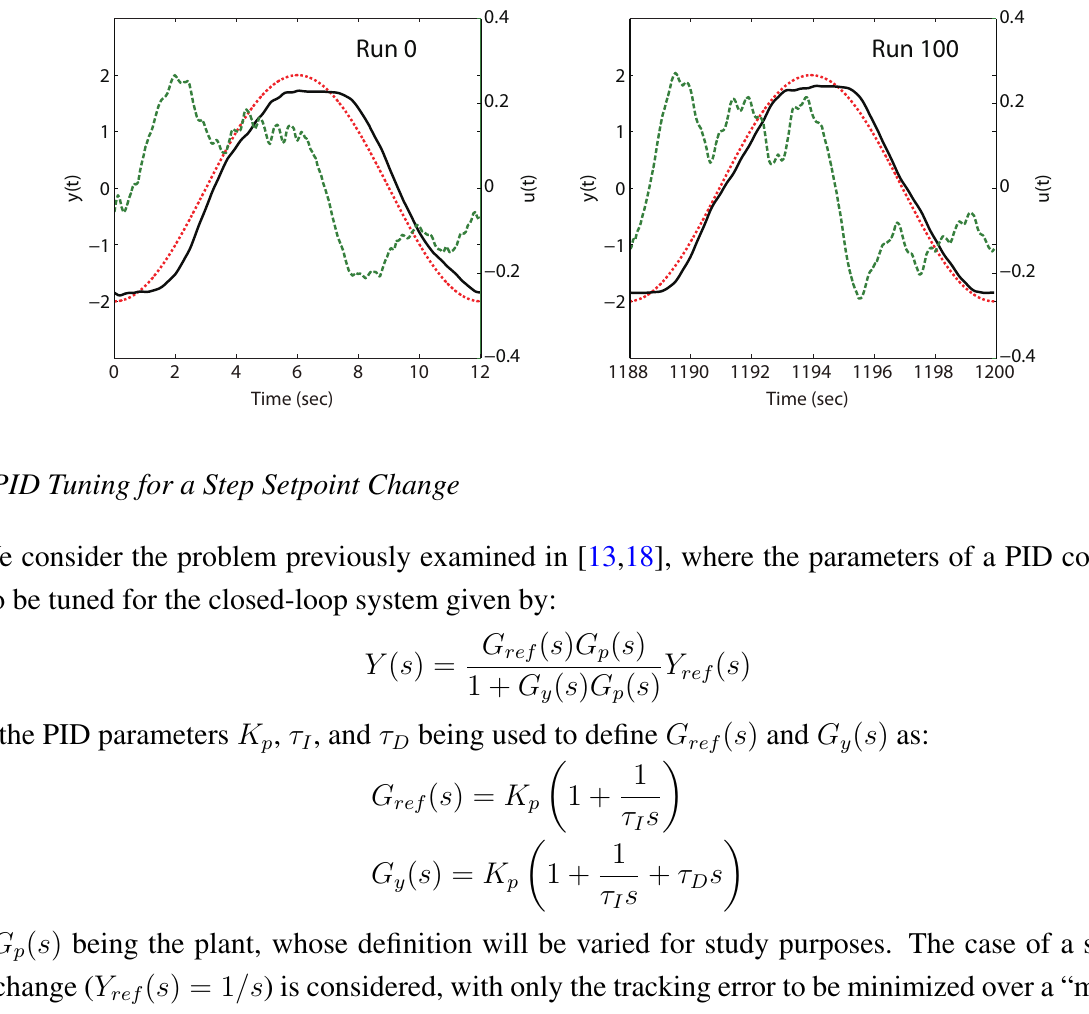
Figure 12. Difference in control input and output profiles between the first and final runs of Problem (19), with the dashed green line used to denote the input (motor voltage)